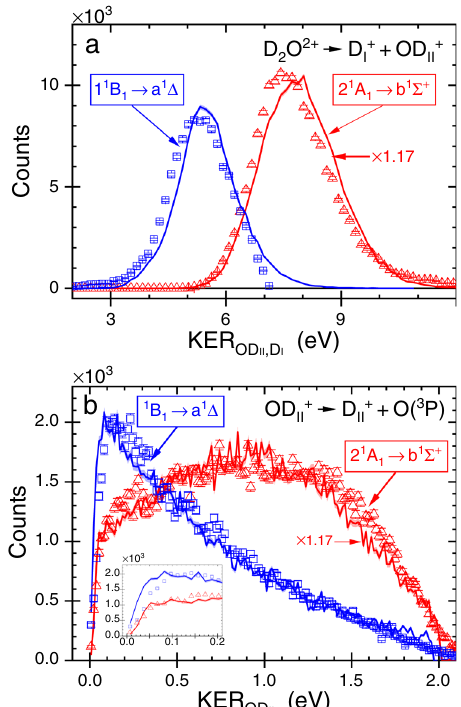
Fig. 6 | The KER distribution in each breakup step ofwater dications. The yield ofsequentialfragmentationofD 2 O 2+ intoD + +D + +O( 3 P)asafunctionof a KER OD and b KER OD (Inset: Zoom-in of low energy range). Comparison of experiment II (symbols and statisticalerrorbars)and normalized theory(solidlines,withshaded range marking the simulation's statistical errors) for the two fragmentation path- ways (and associated states) identi fi ed and separated using Fig. 5a (see text and SupplementaryNote1).Asindicatedonthe fi gure,thetheoryscalingofonepathis a factor of 1.17 larger than the other one (see text). The high energy cutoff in the measured 1 1 B 1 to a 1 Δ data in the upper panel is likely due to the imperfect separation of the two channels by the black-dashed line in FIg. 5. Source data are provided as a Source Data fi